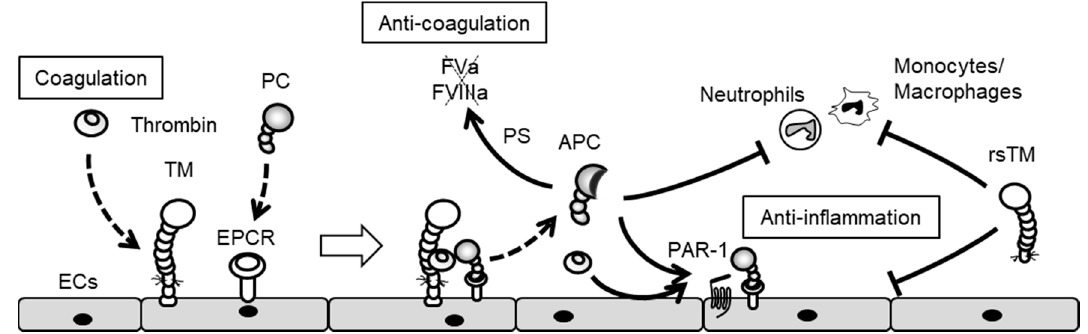
Figure 4. Anti-coagulant and anti-inflammatory effects of the protein C pathway. In a negative feedback loop, the thrombin– thrombomodulin (TM) complex generates activated protein C, which inhibits the blood coagulation cascade by degrading factor Va (FVa) and factor VIIa (FVIIa). In addition, activate protein C (APC) induces anti-inflammatory effects through PAR-1 activation. Both APC and rsTM negatively regulate leukocyte adhesion and EC activation.